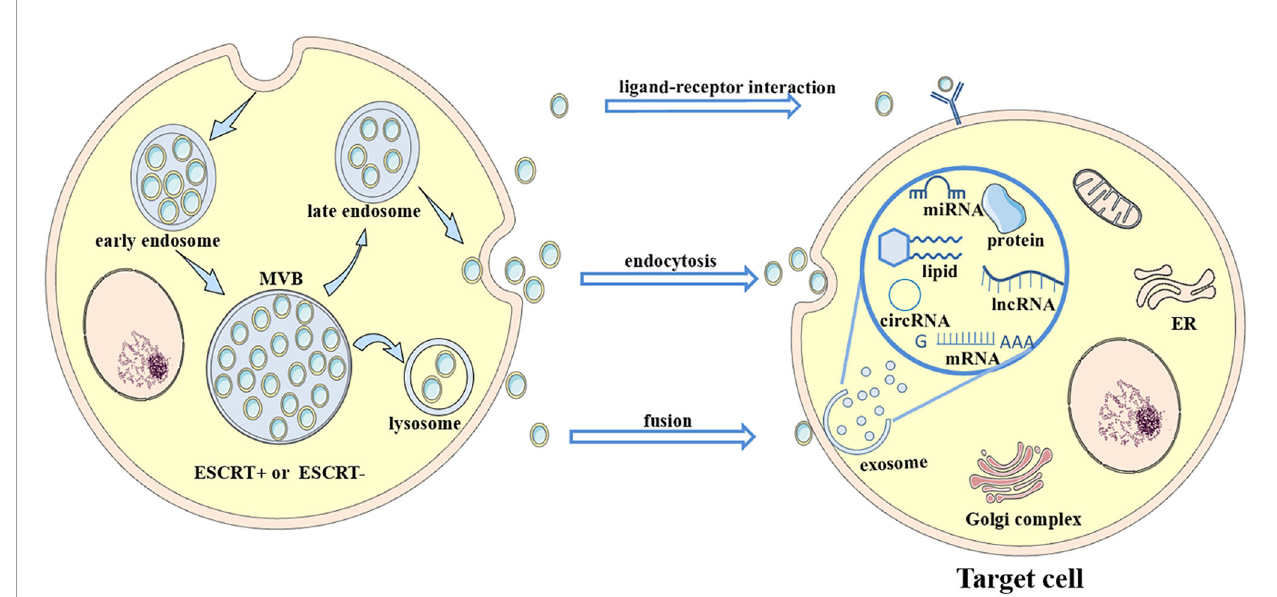
FIGURE 1 | Biogenesis and secretion of exosomes. Multivesicular bodies (MVBs) are formed by plasma membrane invagination followed by process in the rough endoplasmic reticulum (RER) and Golgi body. Then, some MVBs fuse with the plasma membrane to release small vesicles called exosomes to extracellular environment, while some MVBs fuse with lysosomes and are degraded. Exosomes carry abundant cargoes to target sites, such as proteins, lipids and RNAs. Exosomes affect target cells through ligand-receptor interactions, endocytosis or fusion with the plasma membrane of target cells. After an interaction with target cells, exosomes (along with their contents) alter some signaling pathways and target genes, change their expression levels in target cells, and transfer antiviral molecules or other substances into target cells. Thus, the disease condition is aggravated or alleviated. For example, exosomes transfer the CD11/CD18 protein from TAMs to HCC cells and activate the MMP-9 signaling pathway in HCC cells. Then, the migratory potential of HCC cells is